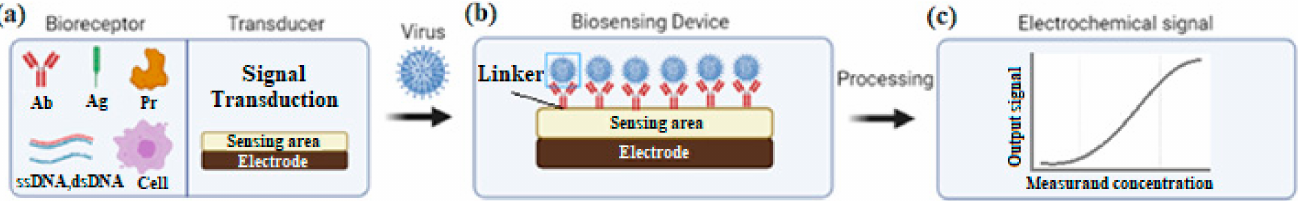
Figure 4. Schematic view of an electrochemical biosensor: ( a ) The surface of these biosensors can be functionalized with various receptors; ( b ) when spotted on the sensing area, these BREs capture the specific targets such as viral particles; and ( c ) the electrochemical signal is reported after the processing steps. Ag: Antigen, Ab: Antibody, Pr: